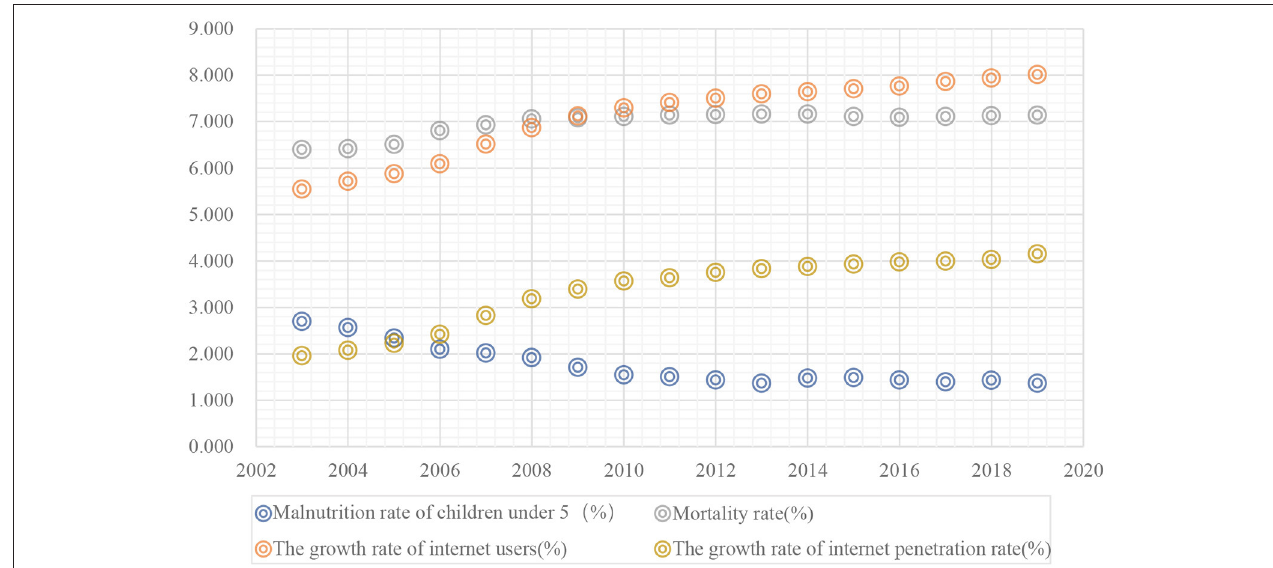
FIGURE 1 | The impact of the digital economy on residents’